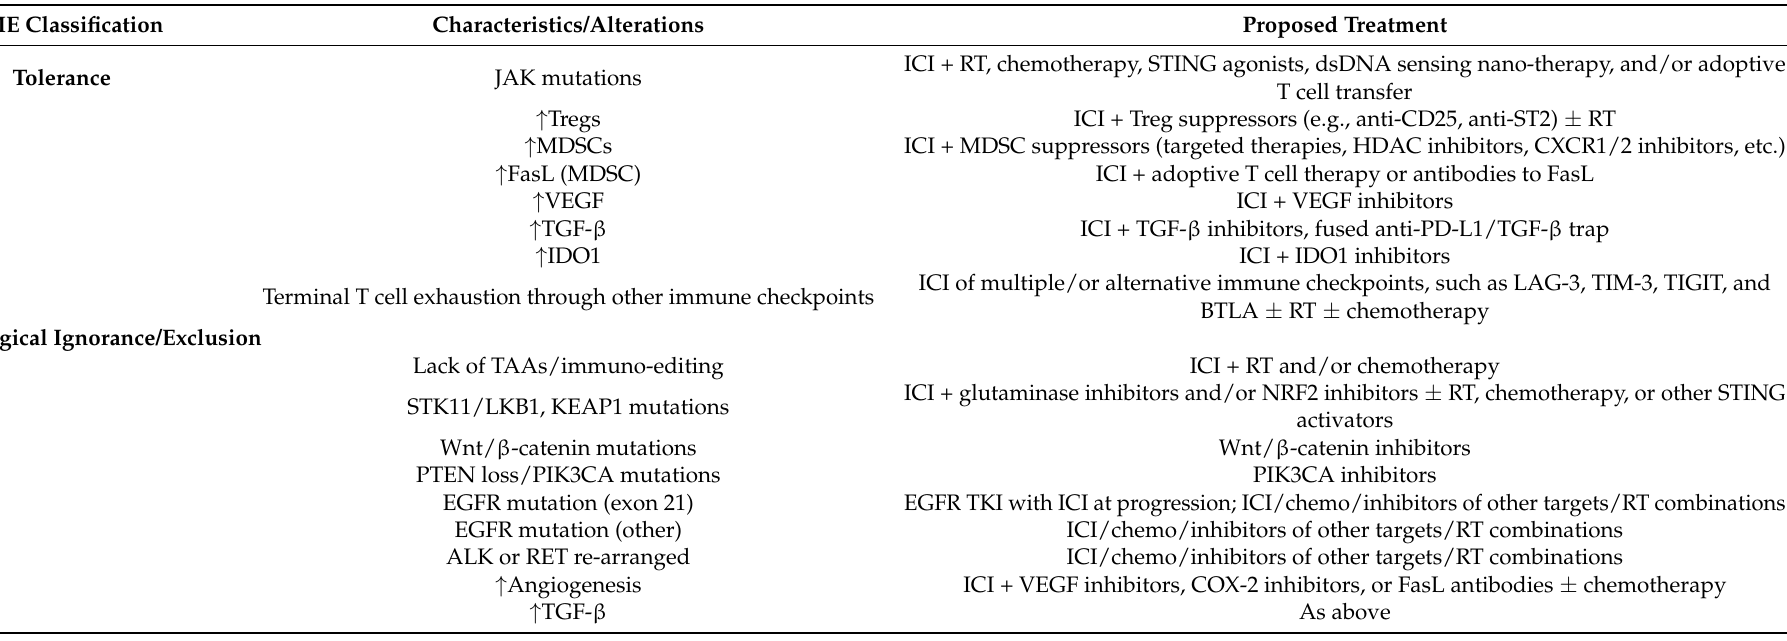
Table 4. Potential treatment strategies to enhance un-inflamed NSCLC’s response to